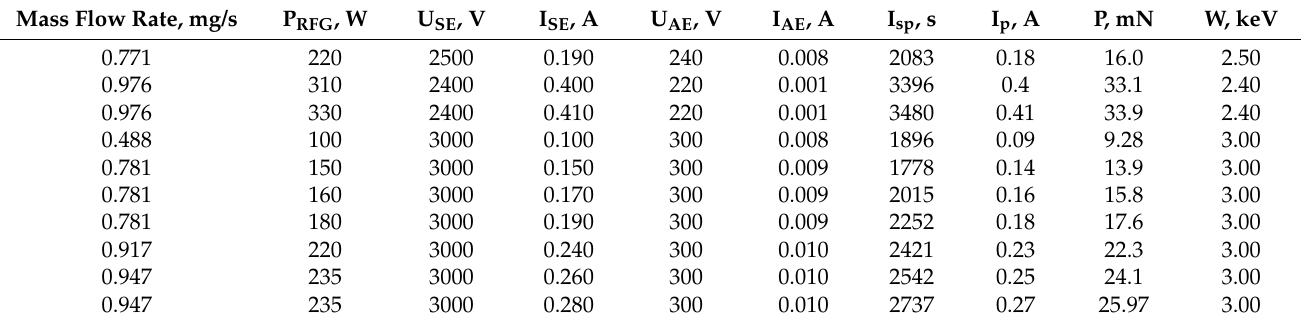
Table 2. Experimental results for the IS with the slit-type